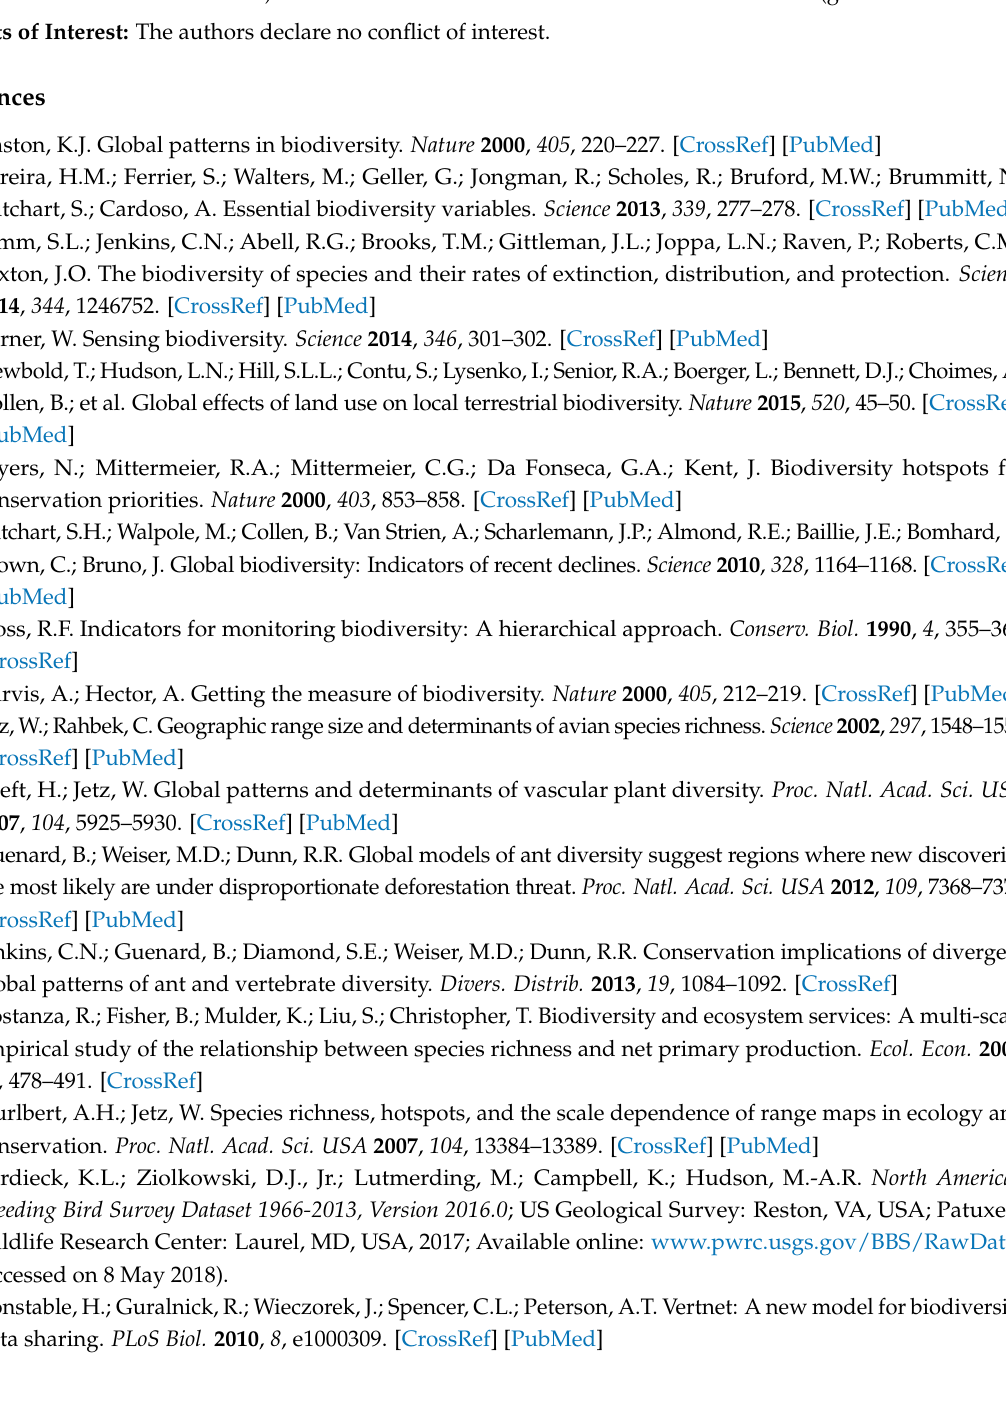
Figure S3: Correlation between predicted species richness and in situ species richness; Table S1: The explained variance of remote sensing metrics in different